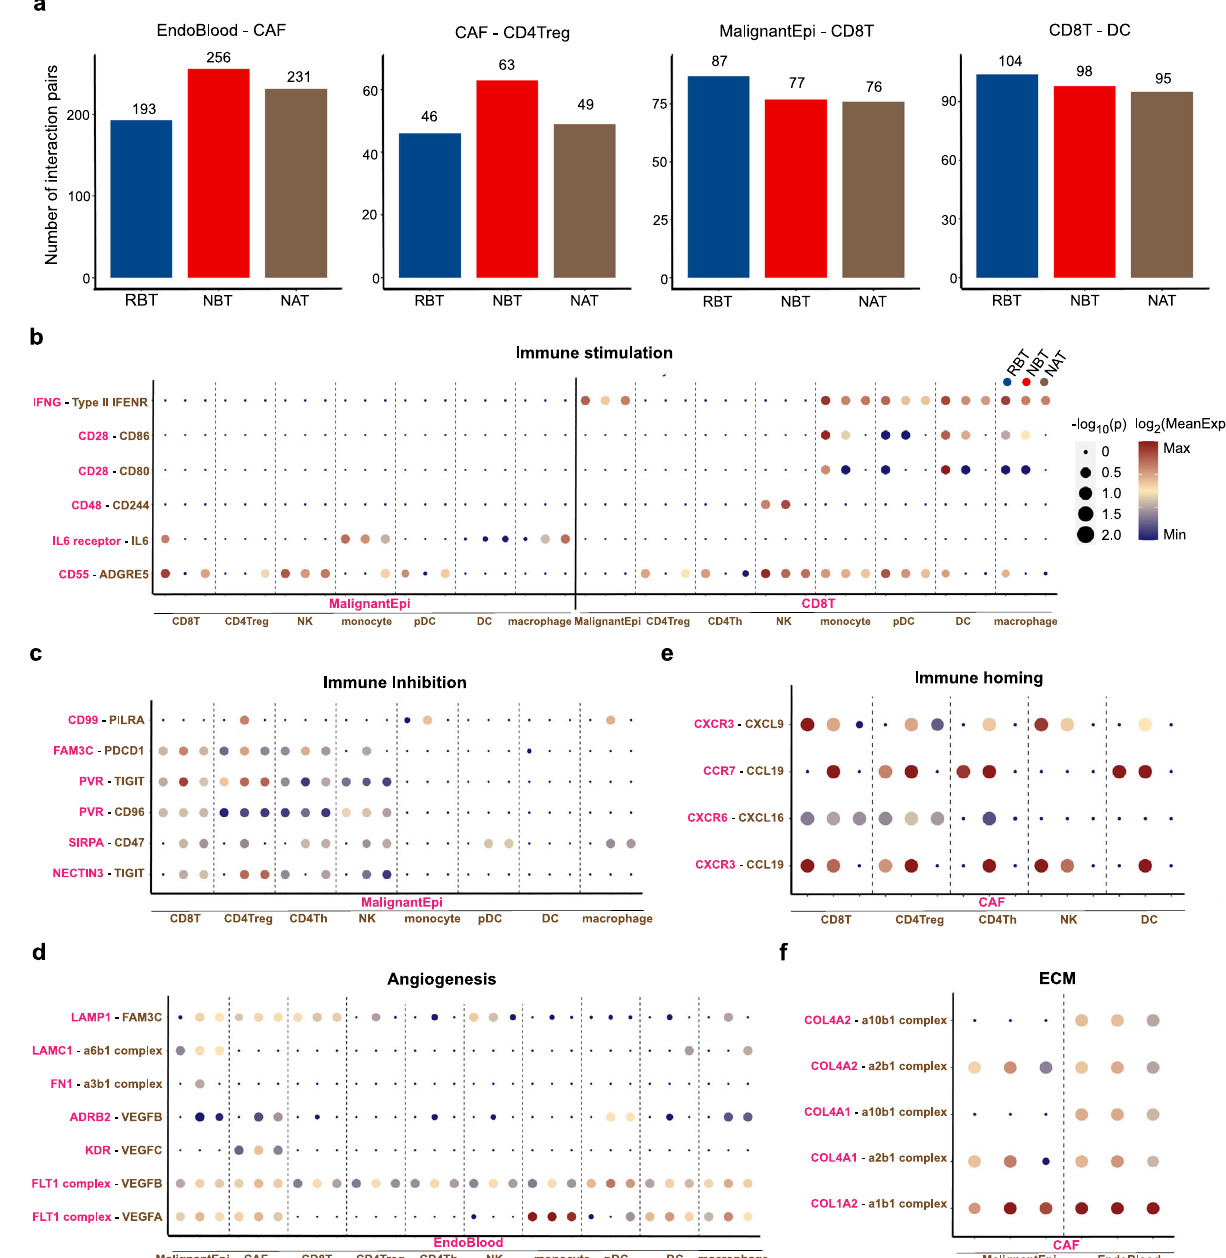
Fig. 5 | Comparison of intercellular interactions among three groups in HPC. a Barplotsshowingdifferentintercellularinteractionnumbersamongthreegroups for four cell type pairs, including EndoBlood and CAF, CAF and Treg, malignant epithelial (MalignantEpi) cells and CD8+T cells, as well as CD8+T cells and DCs. b – f Selected ligand-receptor interaction pro fi les for fi ve important biological functions, including immune stimulation ( b ), immune inhibition ( c ), angiogenesis